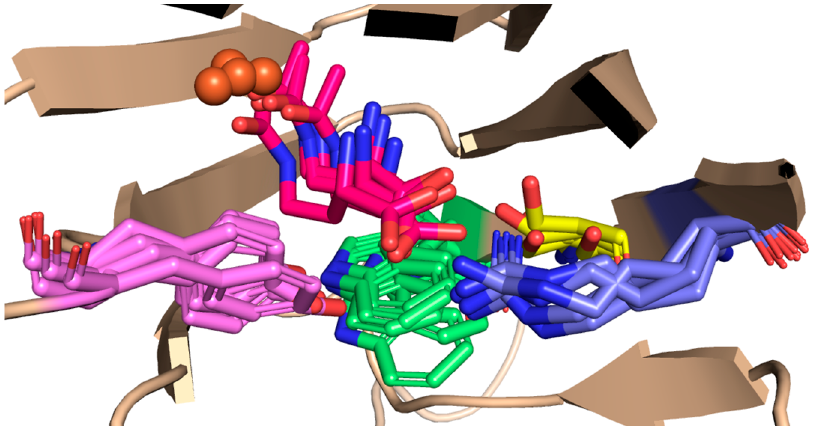
Figure 8. Structural alignment of representative structures correlated to the NAC state in octahe- drally coordinated EctC; the substrate (magenta), Trp21 (green), Arg25 (purple), Tyr52 (pink) and Ser23 (yellow).